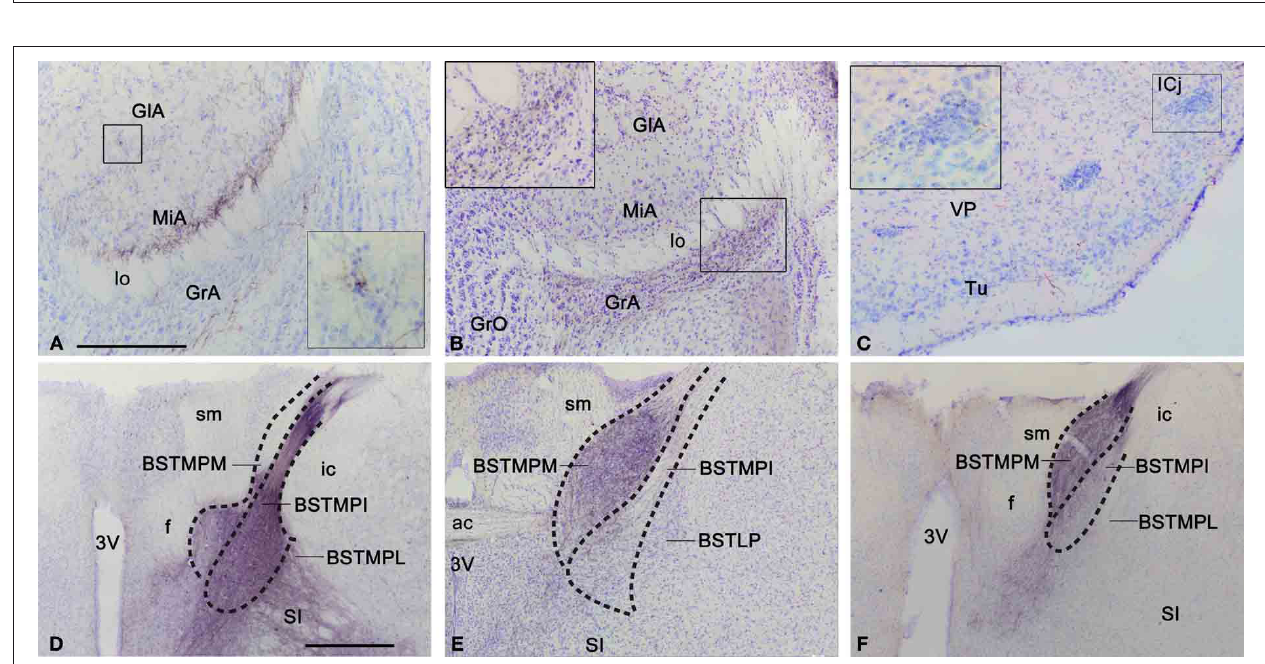
receiving tracer injections intheMeA (A) ,MePD (B), andMePV (C) . (A–C) Note that in allcases dense anterograde labeling isobserved in the vomeronasal amygdala. For abbreviations, see list. Scalebar in A (valid for B and C ): 500 µ m.